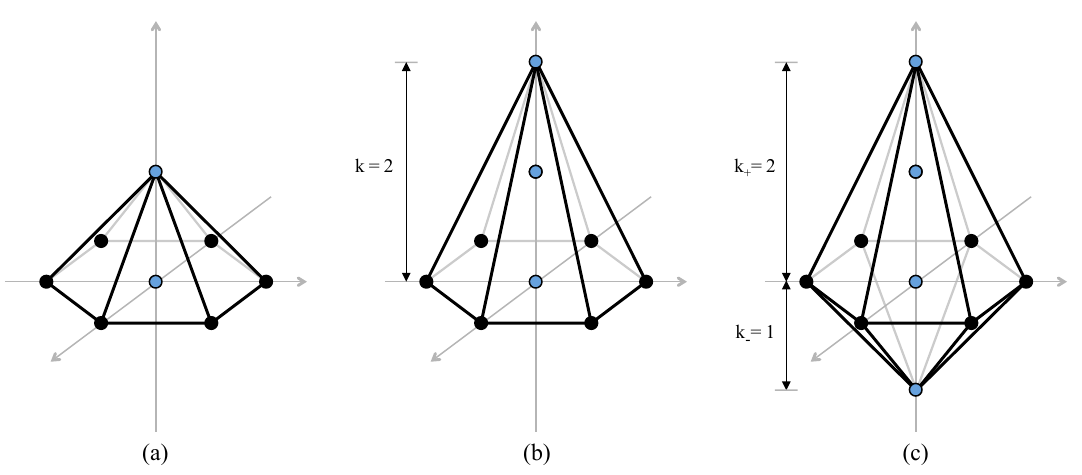
Figure 12. Toric diagrams for: a) the dimensional reduction of dP 3 to dP 3 × C , b) a ( dP 3 × C ) / Z k orbifold with k = 2 and c) an orbifold reduction of dP